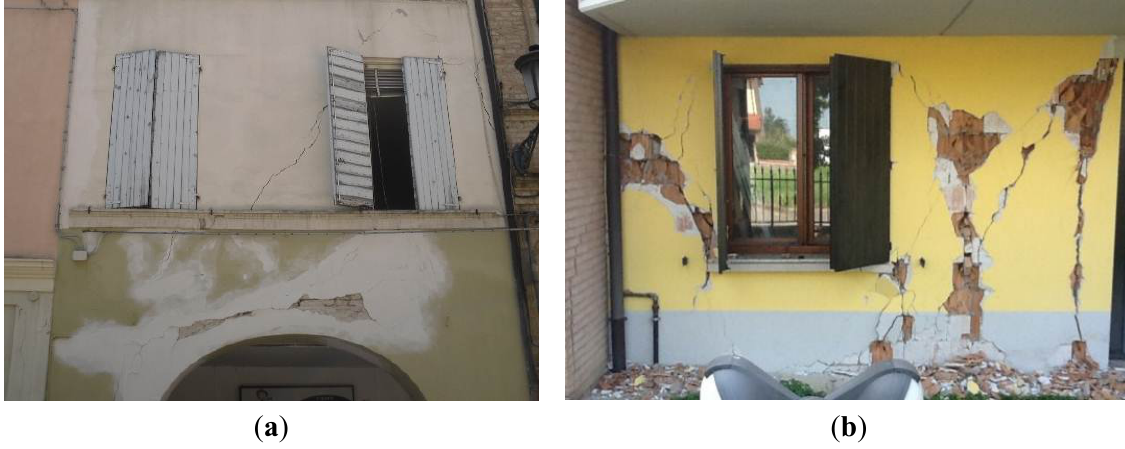
Figure 18. Damage to irregular masonry walls with openings: ( a ) wall irregularity due to different number of openings between two stories; ( b ) wall irregularity due to different opening heights at the same